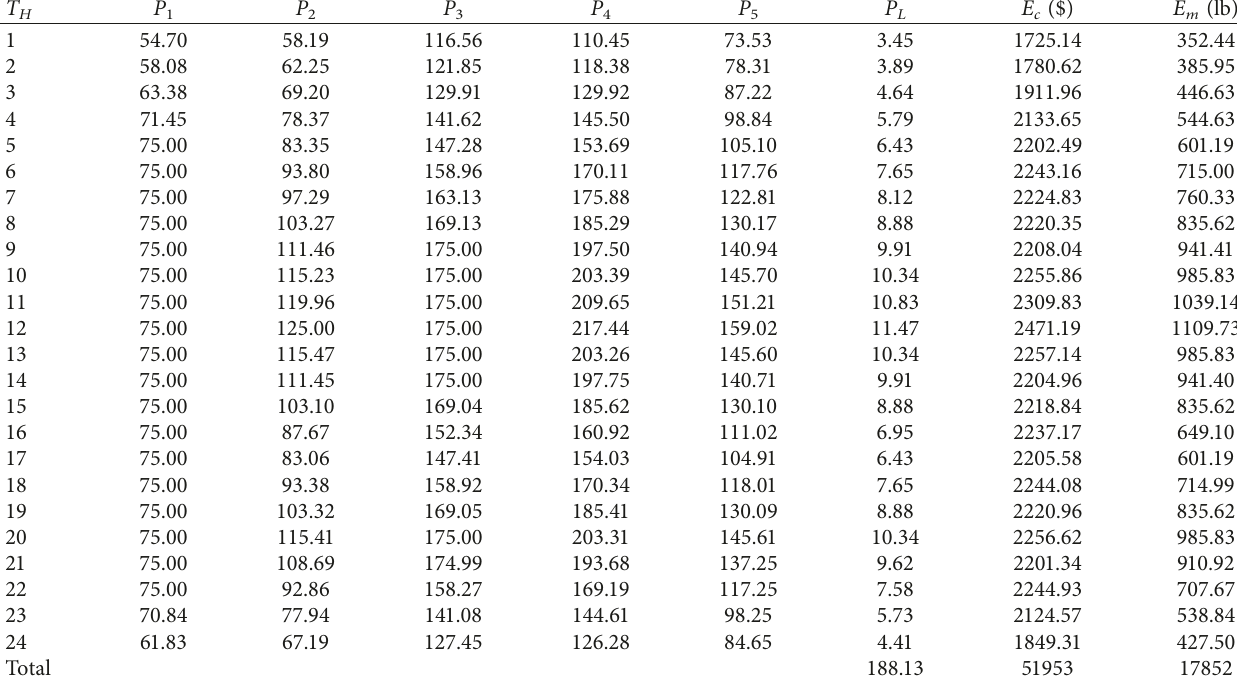
Table 3: Optimal results for Case 1 (optimal